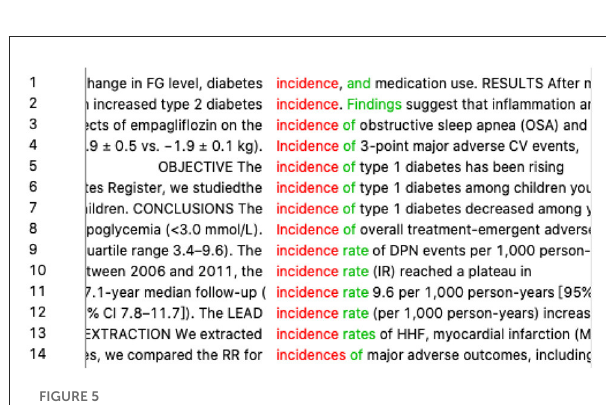
FIGURE2 Concordance lines of “objective*”.